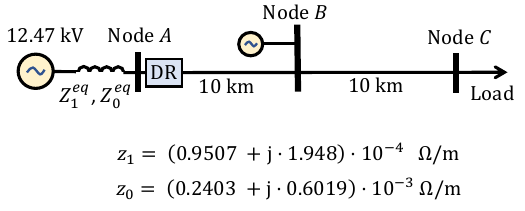
Figure 15. One-line diagramof a simplified distribution feeder.